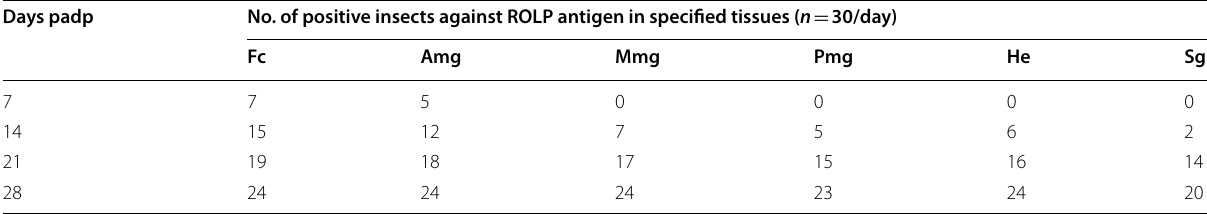
Table 1 Occurrence of ROLP Imp antigen in various tissues of R. dorsalis at different days post-first access to diseased plants (padp) Days padp No. of positive insects against ROLP antigen in specified tissues ( n